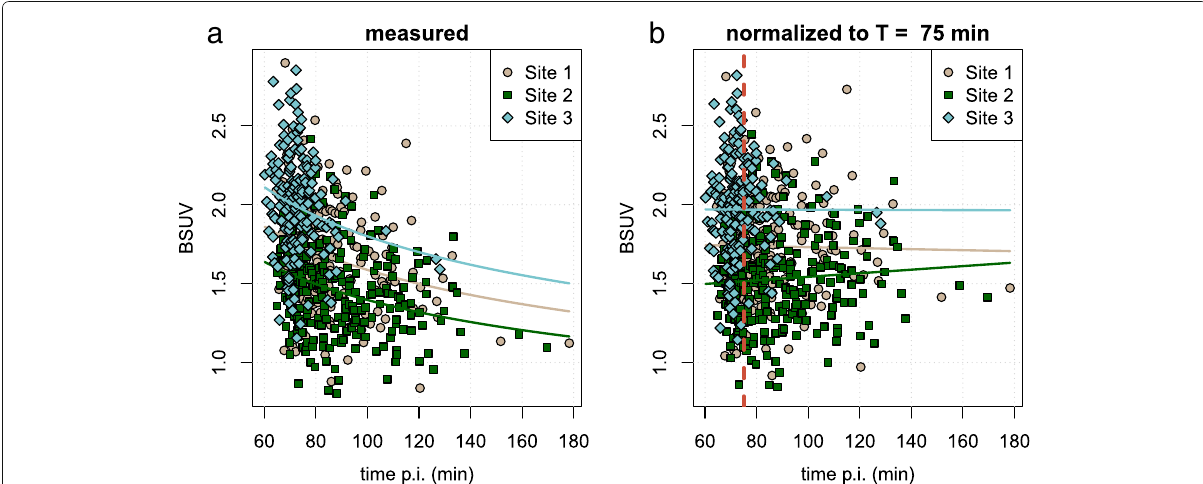
Fig. 2 BSUV as a function of uptake time. a Measured values. Solid lines represent least squares fits according to Eq. 1 (when solving that equation for BSUV ( T ) and fitting for BSUV ( T 0 ) ). b Values normalized to reference time T 0 = 75 min (dashed red line). Solid lines represent least squares fits of straight lines to these